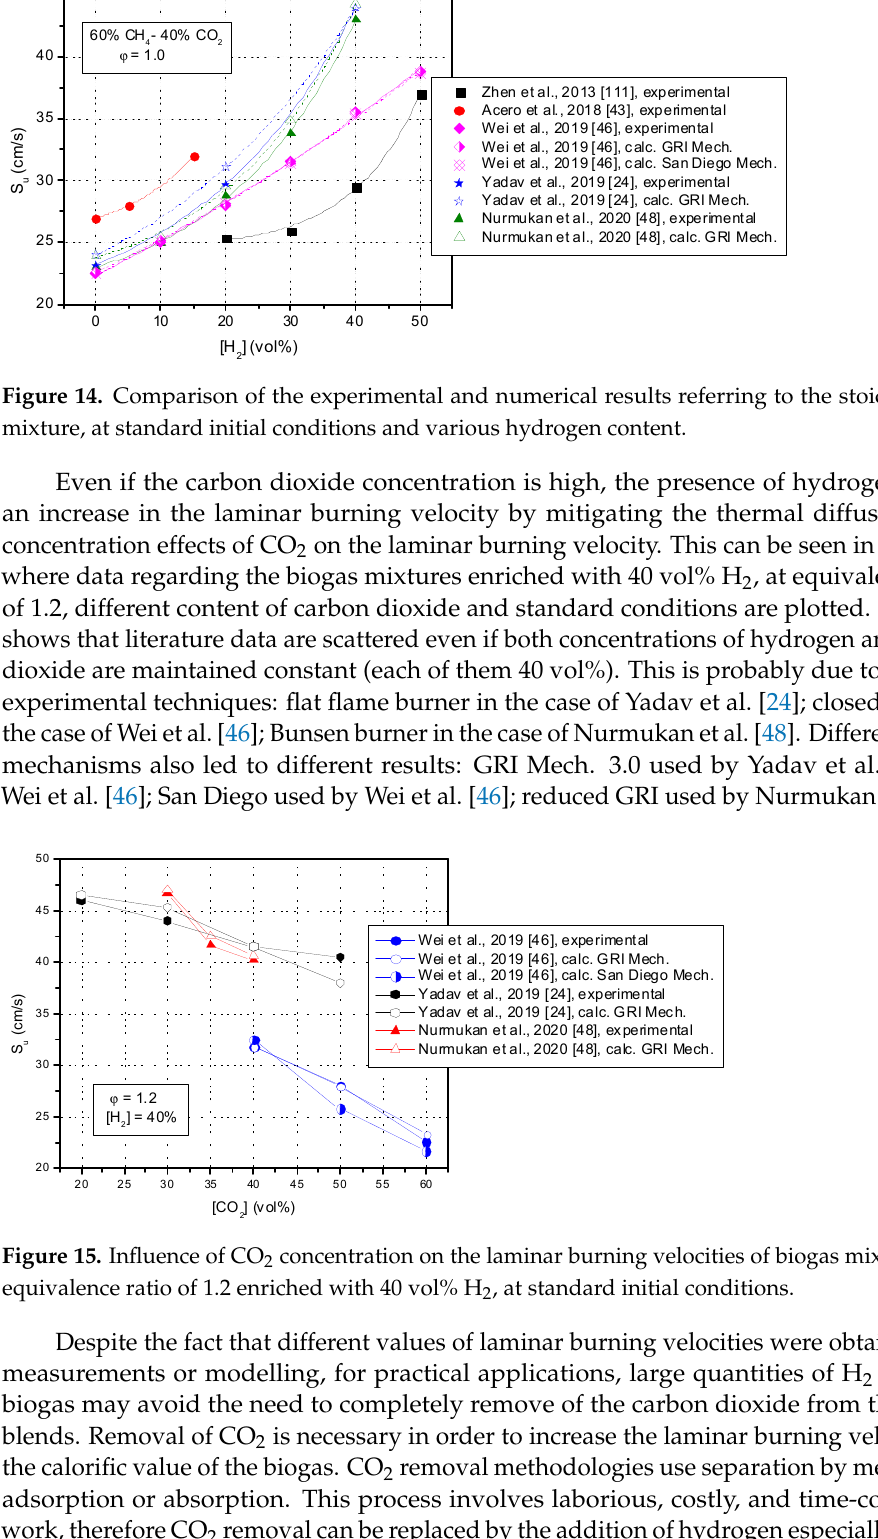
Figure 13. Variation of the laminar burning velocities of H 2 -enriched biogas mixtures at various equivalence ratios and standard initial conditions; Biogas composition: 50% CH 4 –50% CO 2 .